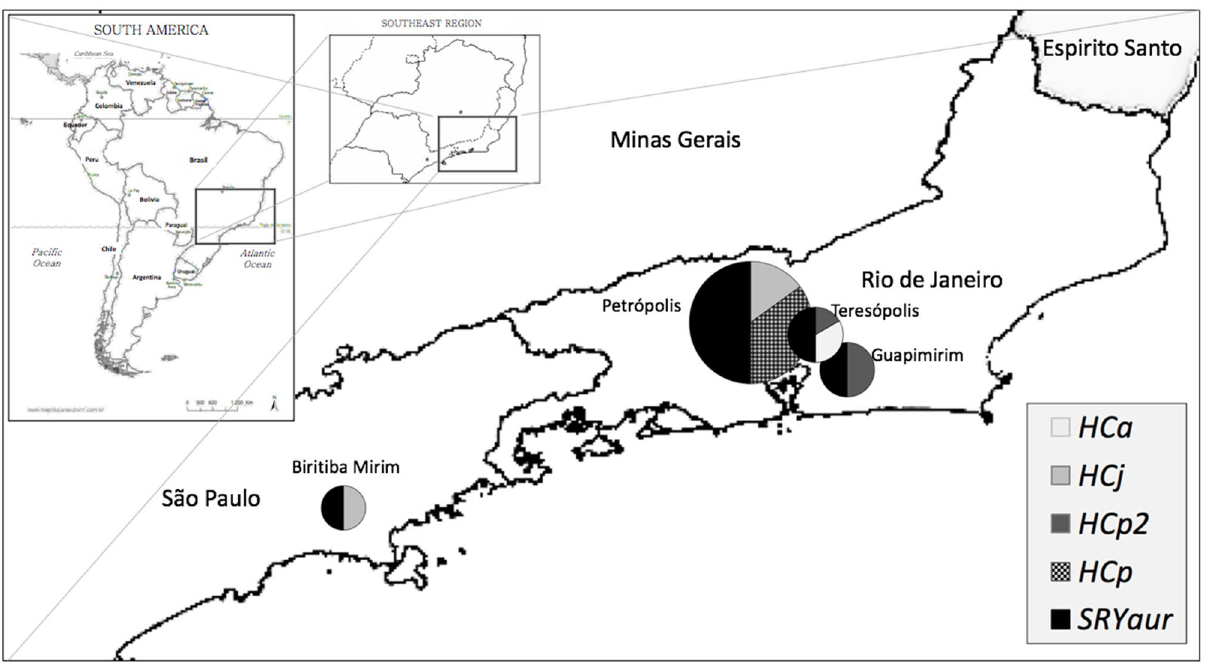
Figure 1. Place of origin and sampling of the 18 individuals of Callithrix sp. studied. ( A ). Map of South America; ( B ). Southeastern Brazil; ( C ). Sampling locations at Rio de Janeiro state: Guapimirim, Teresópolis and Petrópolis. In São Paulo state, only Biritiba Mirim. The size of the circles represents the sample number. Half of the circle in black represents the SRY haplotype with the deletion of nine base pairs exclusive to C. aurita ( SRYaur ), identified in all hybrids. In the other half, the COX2 haplotypes identified among the samples are represented. Two individuals from Guapimirim carried the haplotype of C. aurita (H Ca ). In all the others, the haplotypes of invasive C. jacchus (H Cj ) and C. penicillata (H Cp and H Cp 2) were identified. (Map created by R. S. Carvalho using QGIS 3.16. QGIS Geographic Information System. QGIS Association. http:// www. qgis.